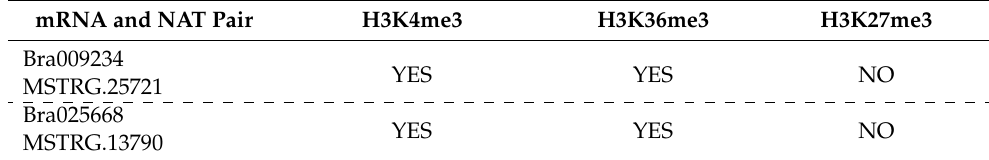
Table 1. Histone modification states in the selected 12 mRNA and their paired